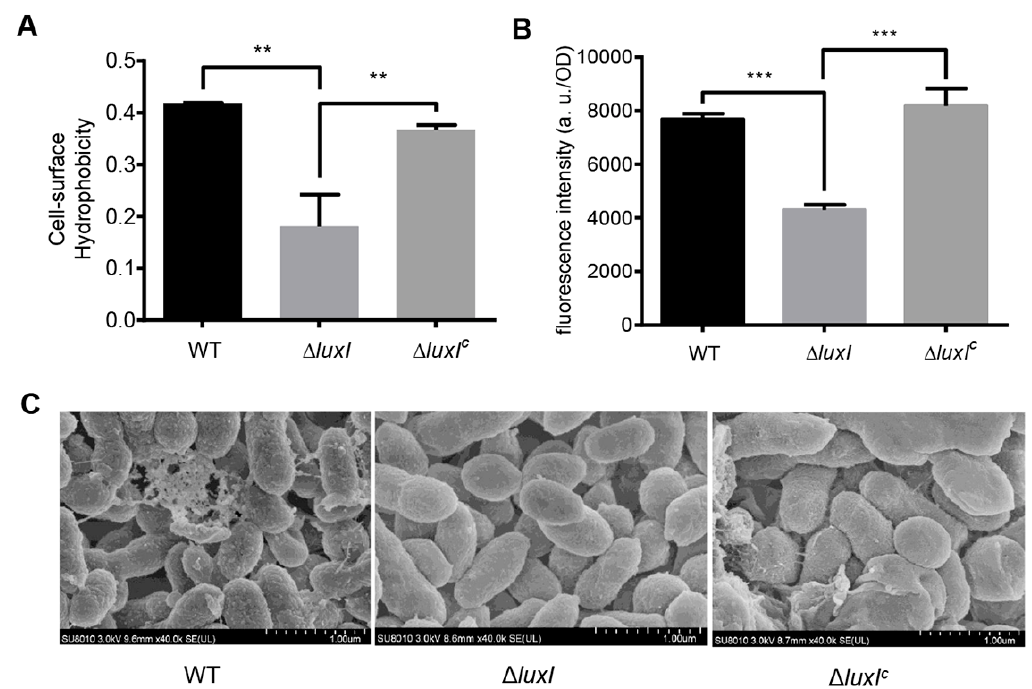
Figure 5. The QS system regulates bacterial cell surface properties. ( A ) Cell surface hydrophobicity of the Δ luxI and its complemented version ( Δ luxI C ). ( B ) Bis-ANS fluorescence intensity. ( C ) Scanning electron micrographs. For ( A , B ), experiments were performed in three biological replicates, and similar trends were observed. The representative data from three separate experiments are